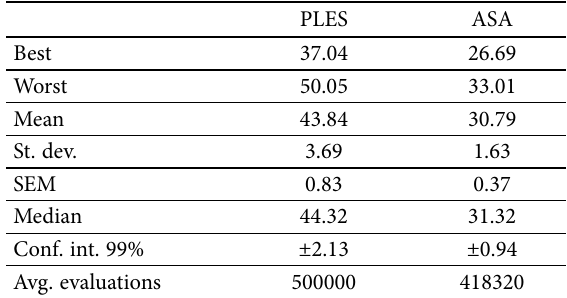
Table 6. Performance of the PLES and the ASA for group transportation in Task 1